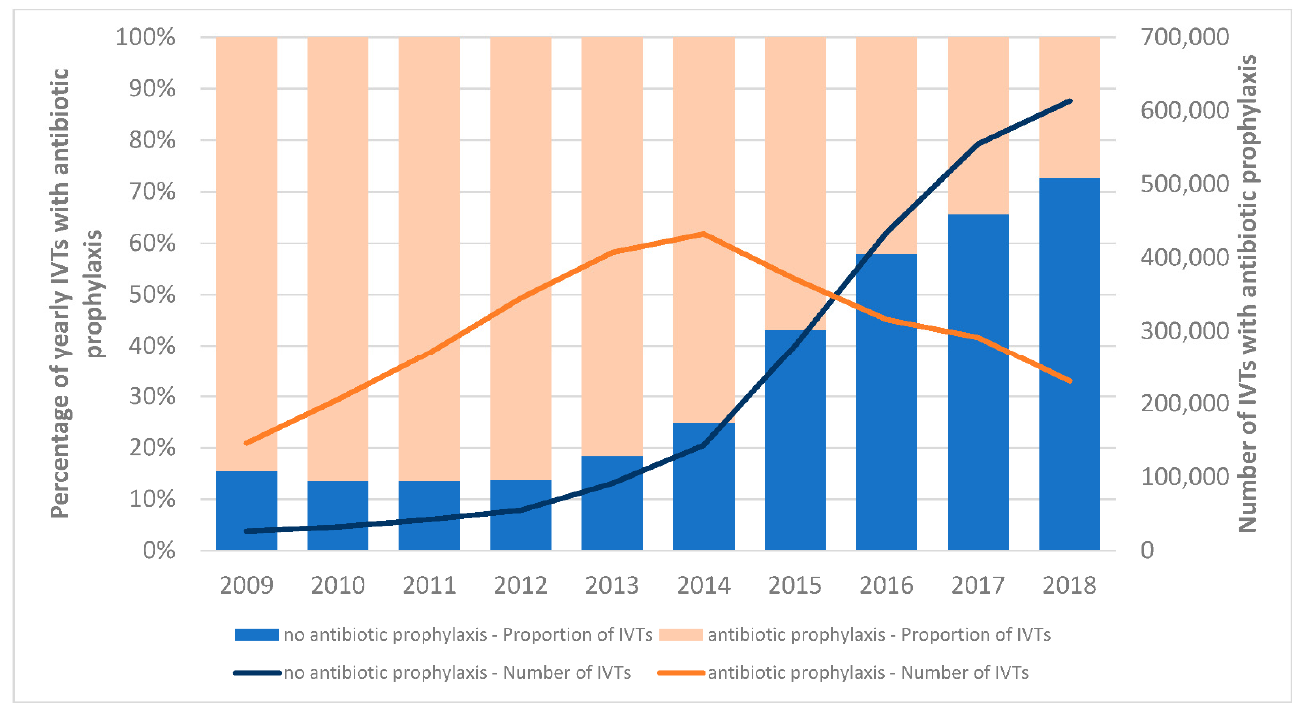
Figure 2. Changes in antibiotic prophylaxis use with IVTs from 2009 to 2018. The years 2009 and 2018 are truncated to allow for the required 42 days of lookback and follow ‐ up.